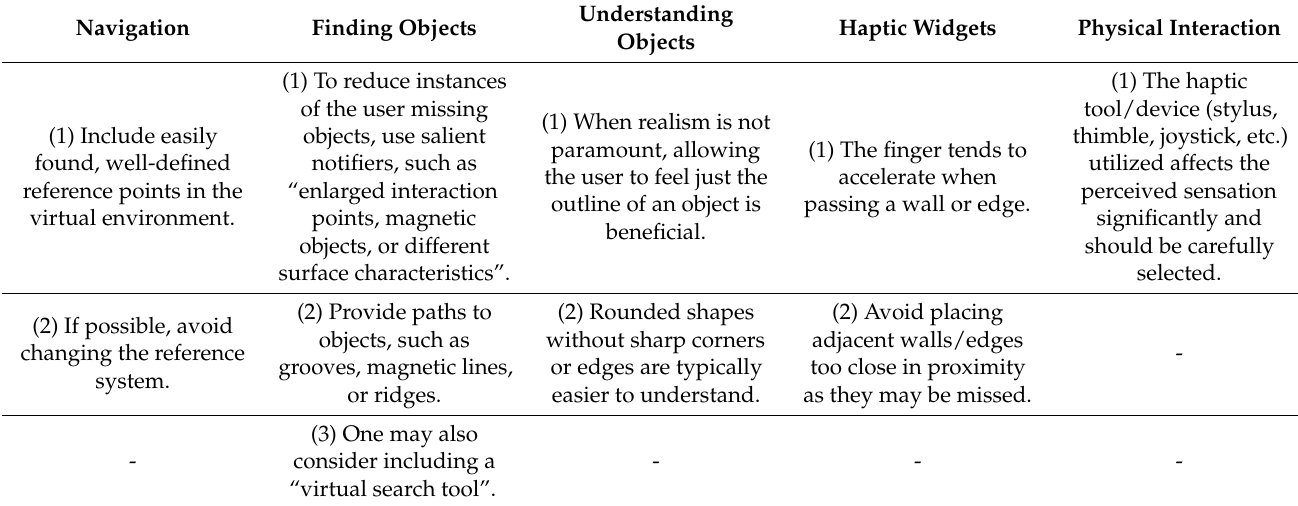
Table 1. Factors that influence the effectiveness of a learning environment (Adapted from